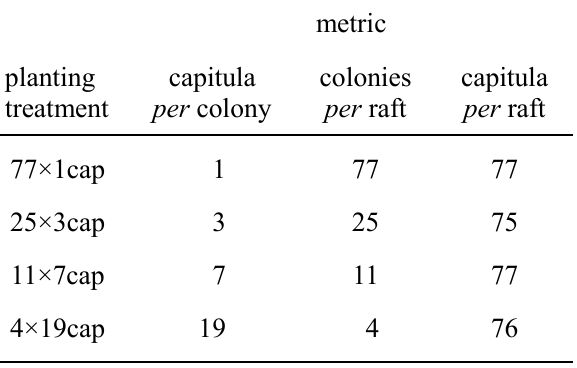
Table 2. Colony sizes and capitulum numbers for the four Sphagnum planting